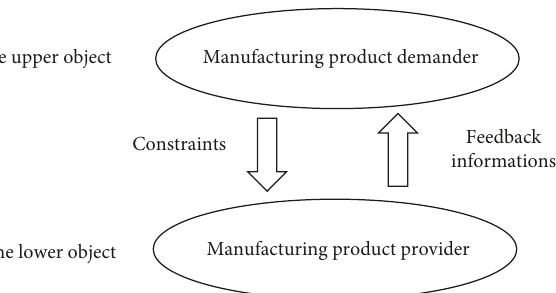
Figure 3: The House of Quality model.